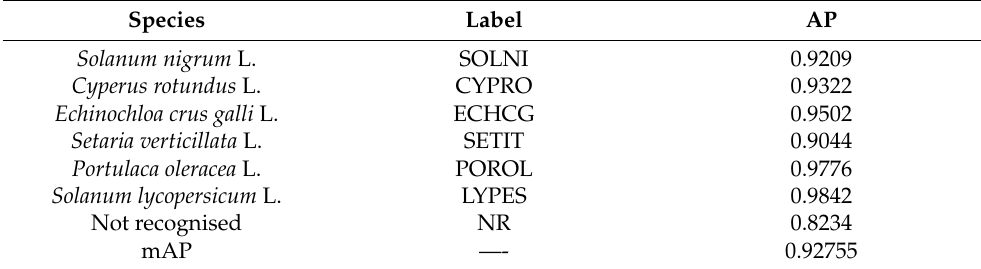
Figure 3. Testing and validation values mAP per epoch and the maximum prediction value on the test set is shown by the green line. Table 2. Prediction mAP values on the test set per species identified by EPPO code as